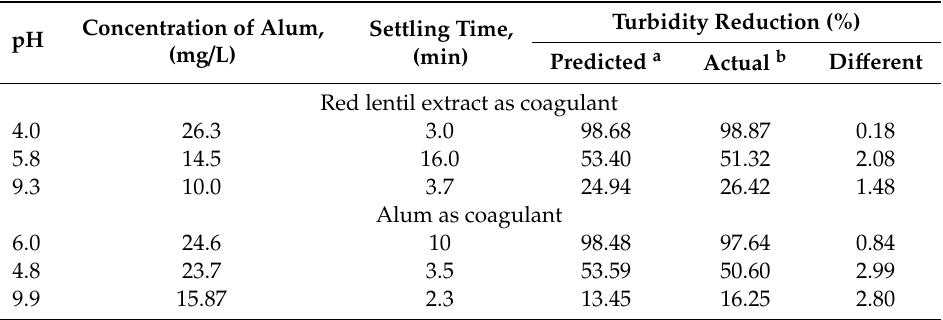
Table 5. Confirmation experiment runs.